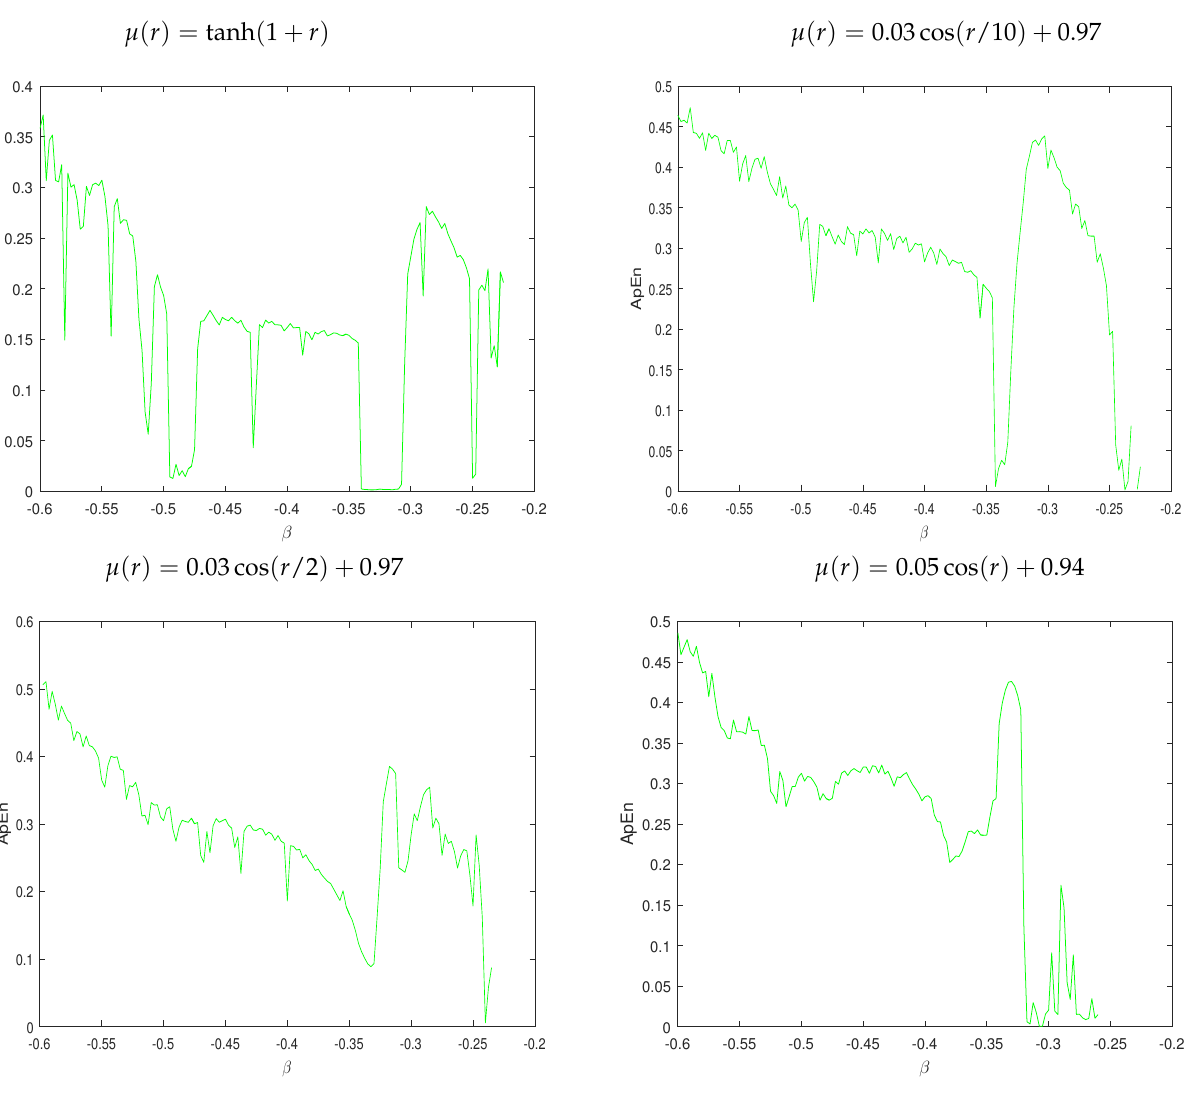
Figure 8. ApEn plots of the Tinkerbell map with the fractional variable-order (8) for several frac- tional